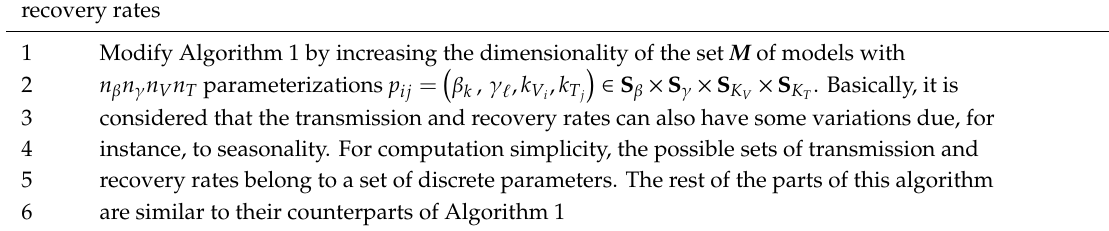
Algorithm 2 Modification of Algorithm 1 by eventual consideration of non-constant transmission and recovery rates